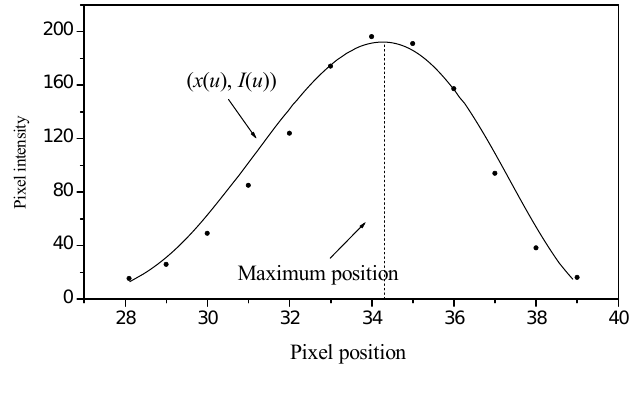
Figure 4. Fitted pixels to a continuous function by Bezier